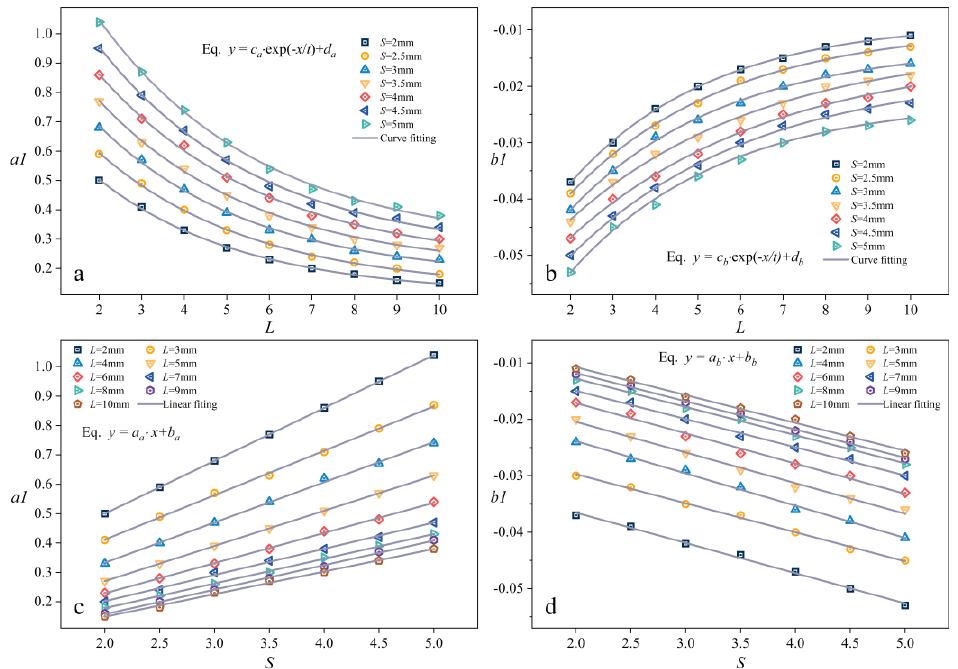
Figure 7. Study of the relationship between S , L , and a1 , b1. ( a ): a1 changes with respect to S and L, L is the abscissa; ( b ): b1 changes with respect to S and L, L is the abscissa; ( c ): a1 changes with respect to S and L, S is the abscissa; ( d ): b1 changes with respect to S and L, S is the abscissa.